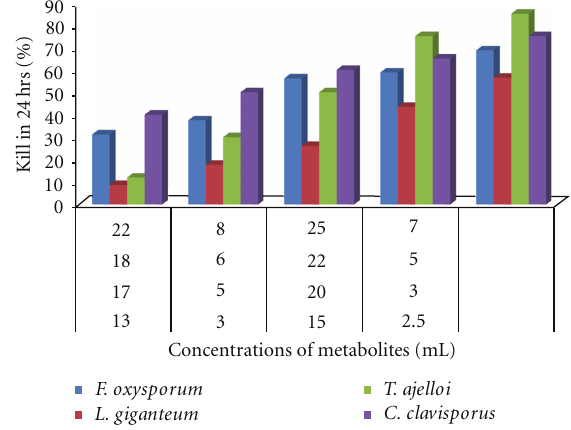
Figure 2: E ff ect of metabolites of Fusarium oxysporum , Lagenidium giganteum , Trichophyton ajelloi, and Culicinomyces clavisporus on Culex quinquefasciatus.